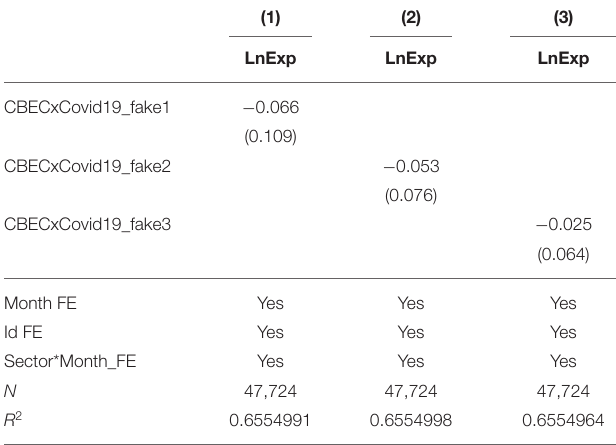
TABLE 3 | Placebo test regression results of virtual time